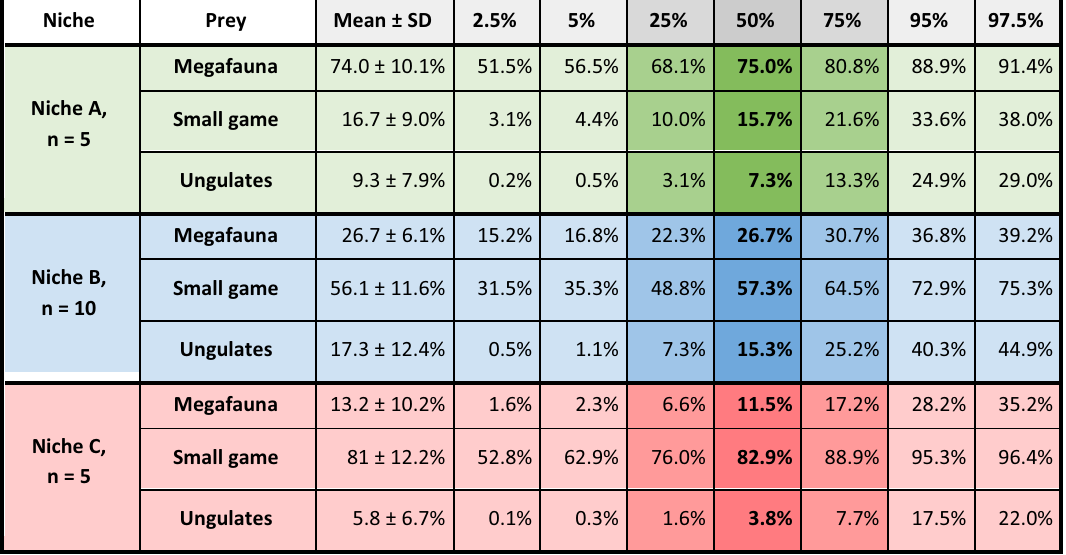
Table 1. Contribution of prey types to the three reconstructed trophic